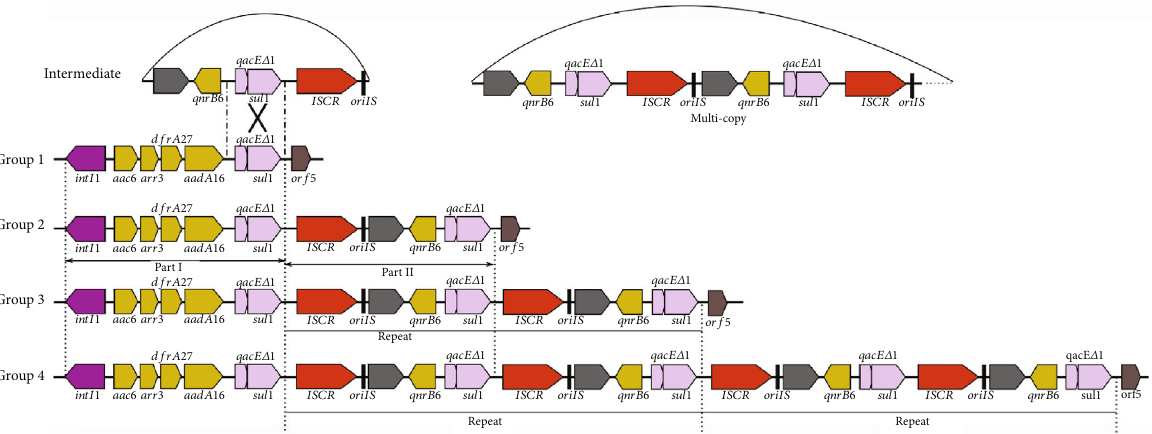
Figure 5: Four groups of sequence diagrams related to the formation of multiple copies of IS CR1 -mediated complex class 1 integrons. The proposed circular intermediate of an aberrant RC replication carrying sdr-qnrB6- △ qacE-sul1 is shown above. The cross symbol represents a possible homologous recombination event. The sequence in the rectangle represents the starting point of the homologous